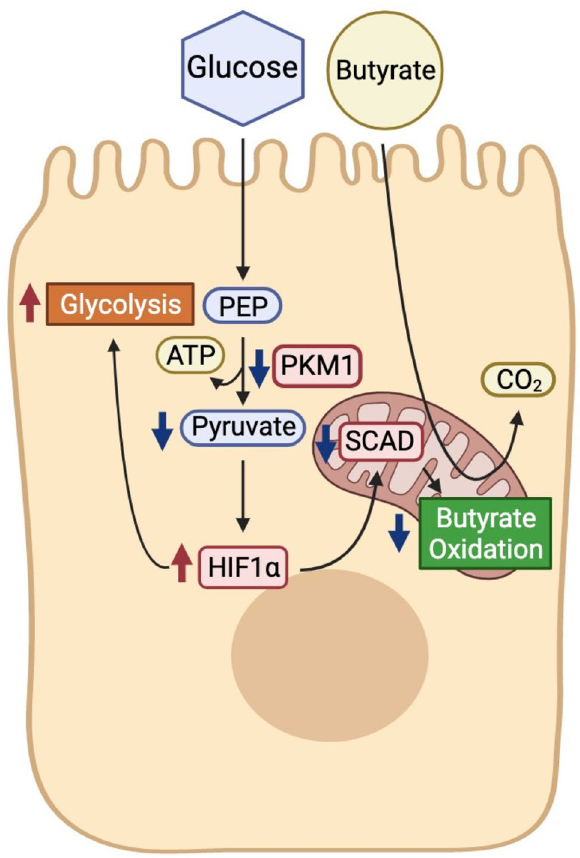
Figure 8. Model of PKM1 regulation of cellular metabolism in cancerous colonocyte. Working model of pathways regulating butyrate oxidation. In this model, the downregulated metabolic enzyme PKM1 is a key factor in the shift of cancerous colonocytes from oxidative metabolism toward aerobic glycolysis. The loss of PKM1 in cancerous colonocytes leads cells to increase glycolysis through reduction of SCAD along with an increase in HIF1α due to a decrease in pyruvate levels. The increase in HIF1α and the decrease in SCAD together explain the lower butyrate oxidation in CRC